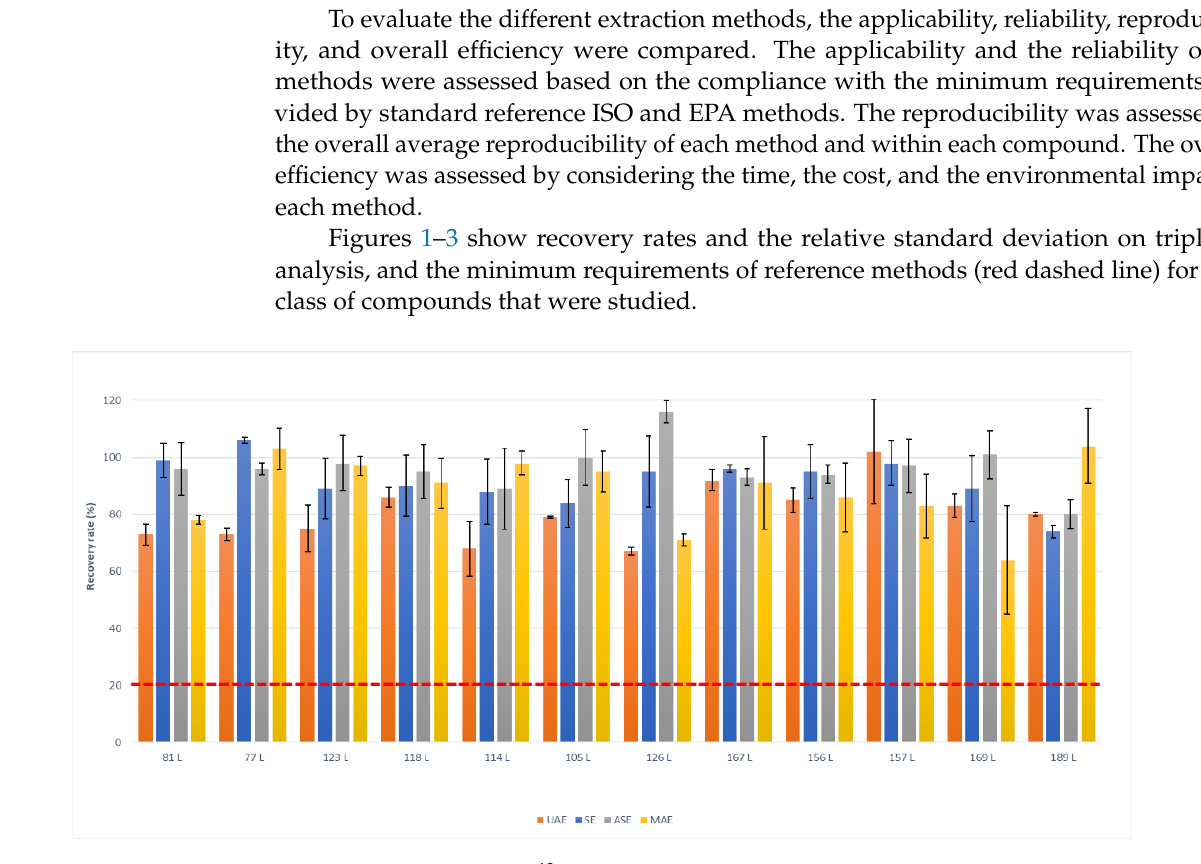
Figure 1. Recovery rates (%) and standard deviation of 13 C-dl-PCBs (labeled with “L”) by ultrasonic assisted (UAE), Soxhlet (SE), accelerated solvent (ASE), and Microwave assisted (MAE) extractions. Each procedure was performed in triplicate. The dashed red line is the minimum acceptable recovery rate (ISO16000-14).